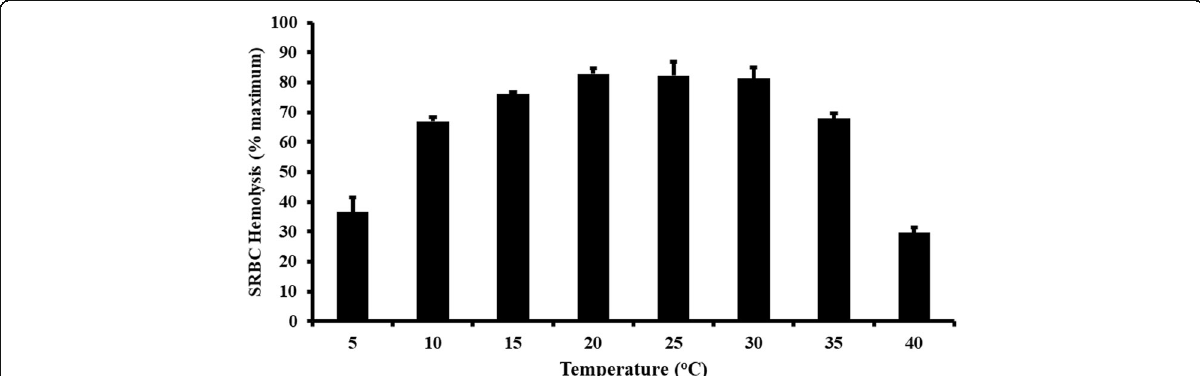
Fig. 3 Temperature-dependent hemolysis of sheep red blood cells (SRBCs) by plasma from Crotalus viridis . SRBCs (1%, v / v ) were incubated with an equal volume of 25% plasma of C. viridis for 1 h and at different temperatures. The samples were centrifuged, and the optical densities of the supernatants were measured at 540 nm and expressed as the % maximum as compared to a hemolysis positive control. The results represent the means ± standard deviations for four independent